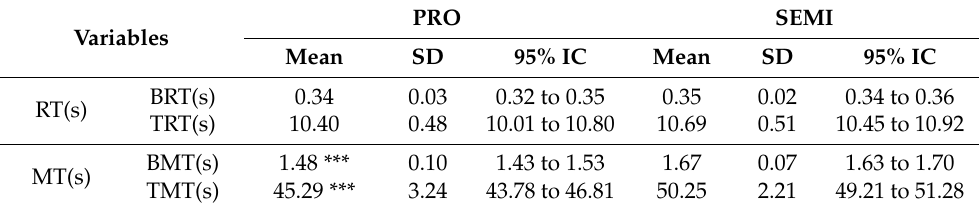
Table 4. Reaction and movement times determined during the RRSA 5COD test for both